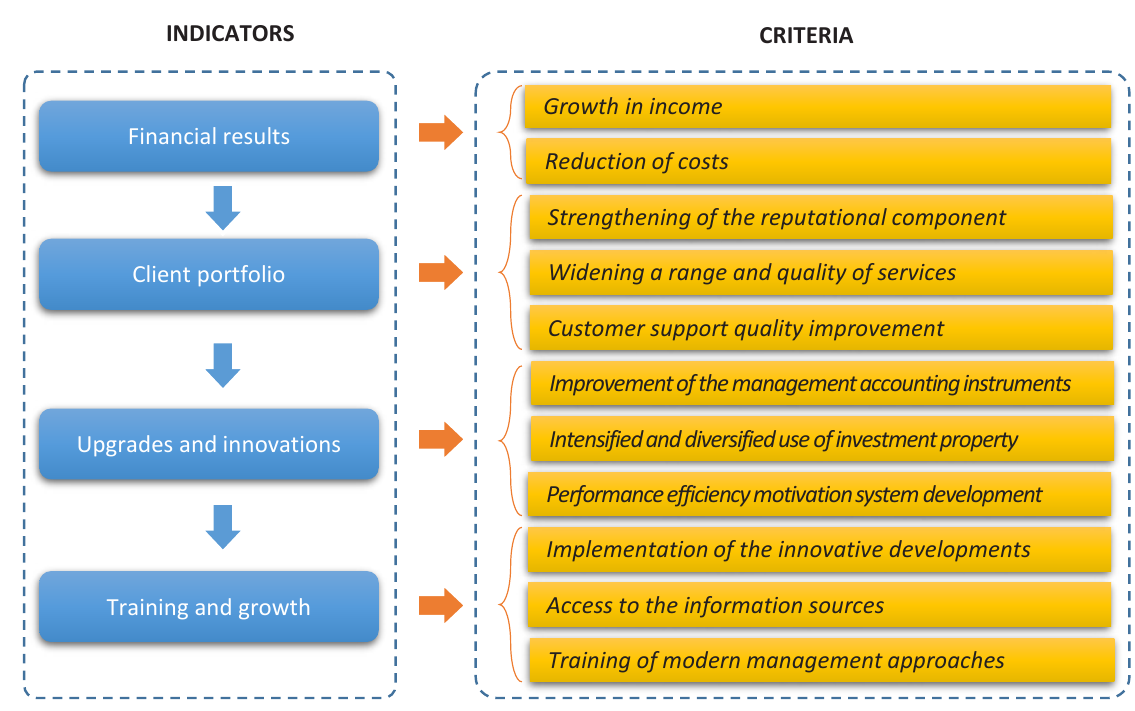
Figure 4. Investment property management harmonized indicator